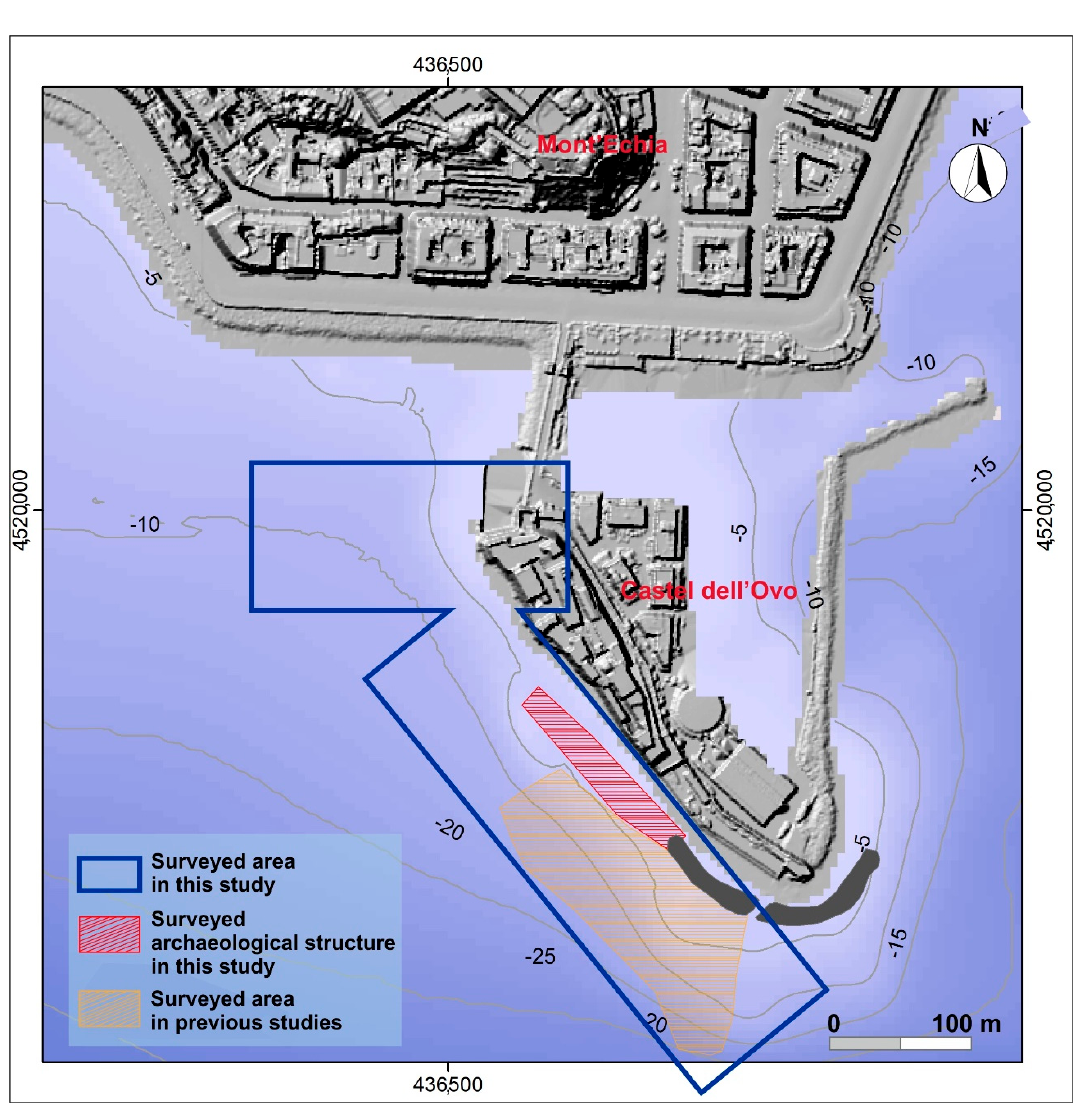
Figure 3. Location map of previous underwater surveys carried out by the Centro Studi Subacquei in the 1980s and [28].